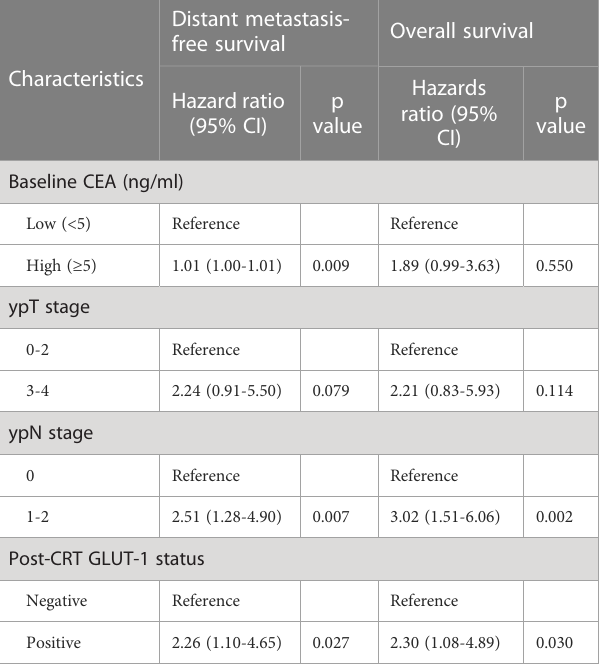
TABLE 3 Results of multivariate Cox analysis for distant metastasis-free survival and overall survival.